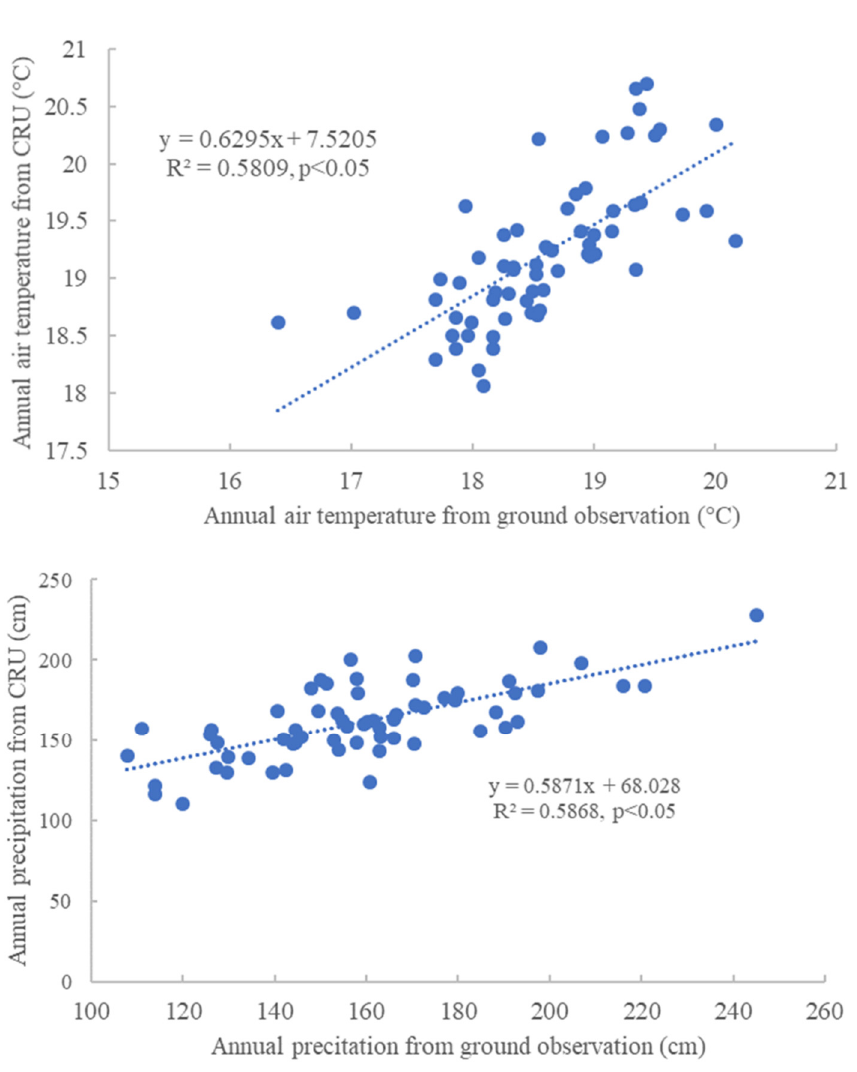
Figure 2. The correlations in the data from the local weather station at Escambia Experimental.